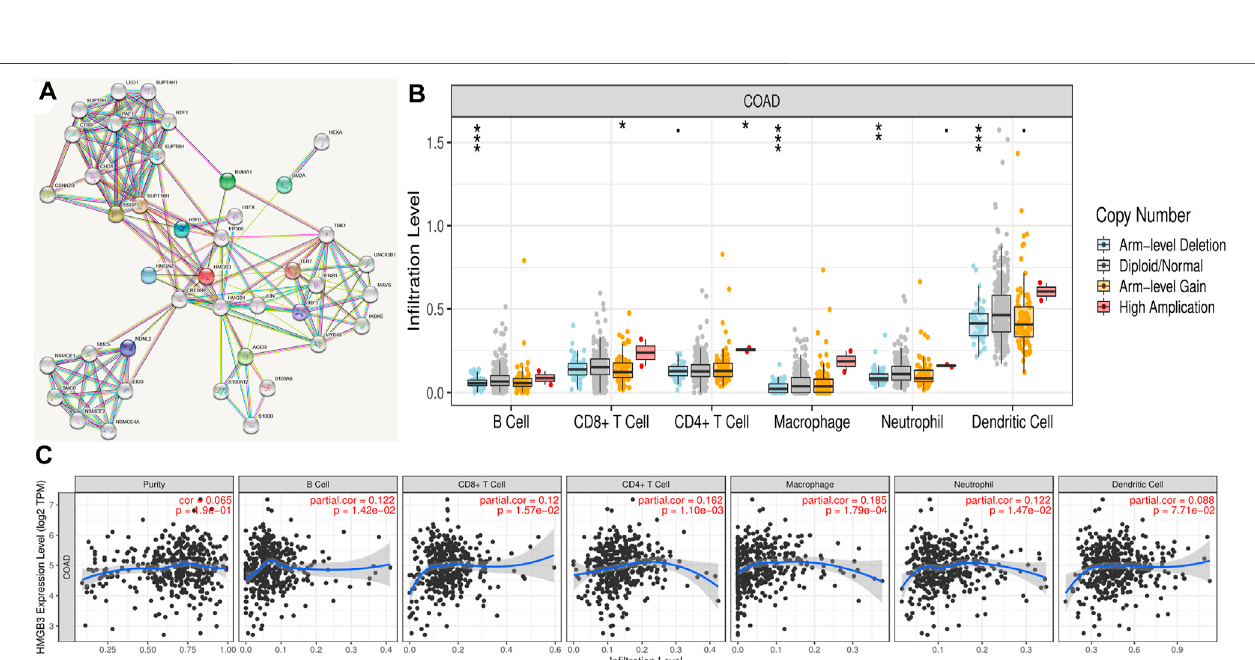
FIGURE6| CorrelationanalysisofthetranscriptofgeneofHMGB3withtheimmunein fi ltrationinCOAD. (A) GeneregulatorynetworkofHMGB3. (B) HMGB3copy number variation affects the in fi ltration level of CD8+ T cells, macrophages in CRC. * p < 0.05. (C) The expression of HMGB3 was no signi fi cant relationship with tumor purity, the level of in fi ltration of CD8+ T cells, CD4+ T cells, macrophages, neutrophils, and dendritic cells in COAD.